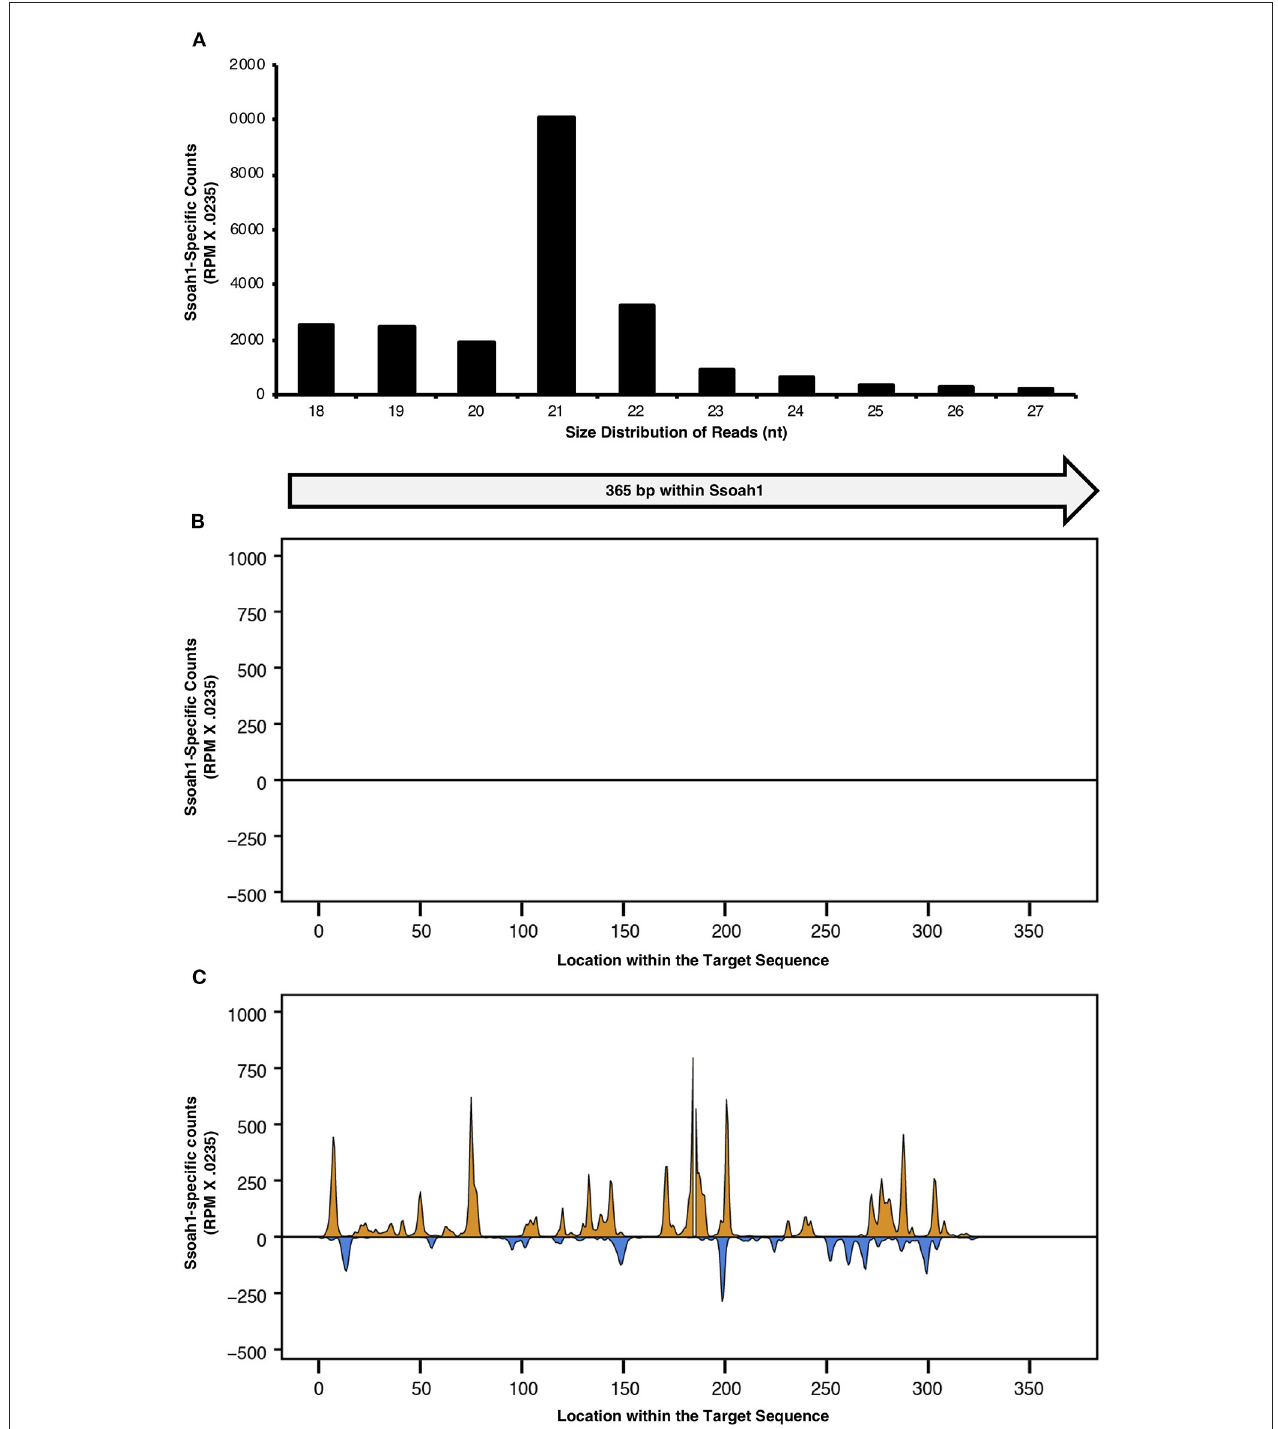
FIGURE 3 | Total sRNAs were profiled from Traff soybean plants bombarded with pBPMV -OA and pBPMV-EV. The size distribution of sRNA reads < 27 nt and corresponding to the 365 nt target within Ssoah1 were normalized to a count, using the conversion factor of 0.0235 X reads per million (RPM). (A) The size distribution of Ssoah1-dsRNA-derived sRNAs corresponding to Ssoah1 from a pBPMV-OA single plant are presented for sRNAs ranging from 18 to 27 nt. The 5 ′ end of 18–27 nt sRNAs from plants containing (B) pBPMV-OA and (C) pBPMV-EV vectors were aligned to the 365 nt sequence cDNA sequence used for silencing construct development. Antisense reads are presented in orange and sense reads are presented in blue.